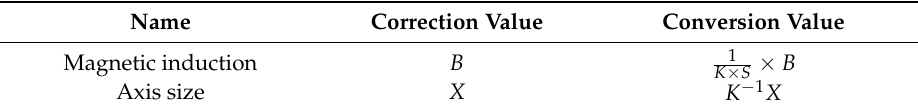
Table 7. Correction value and conversion value.